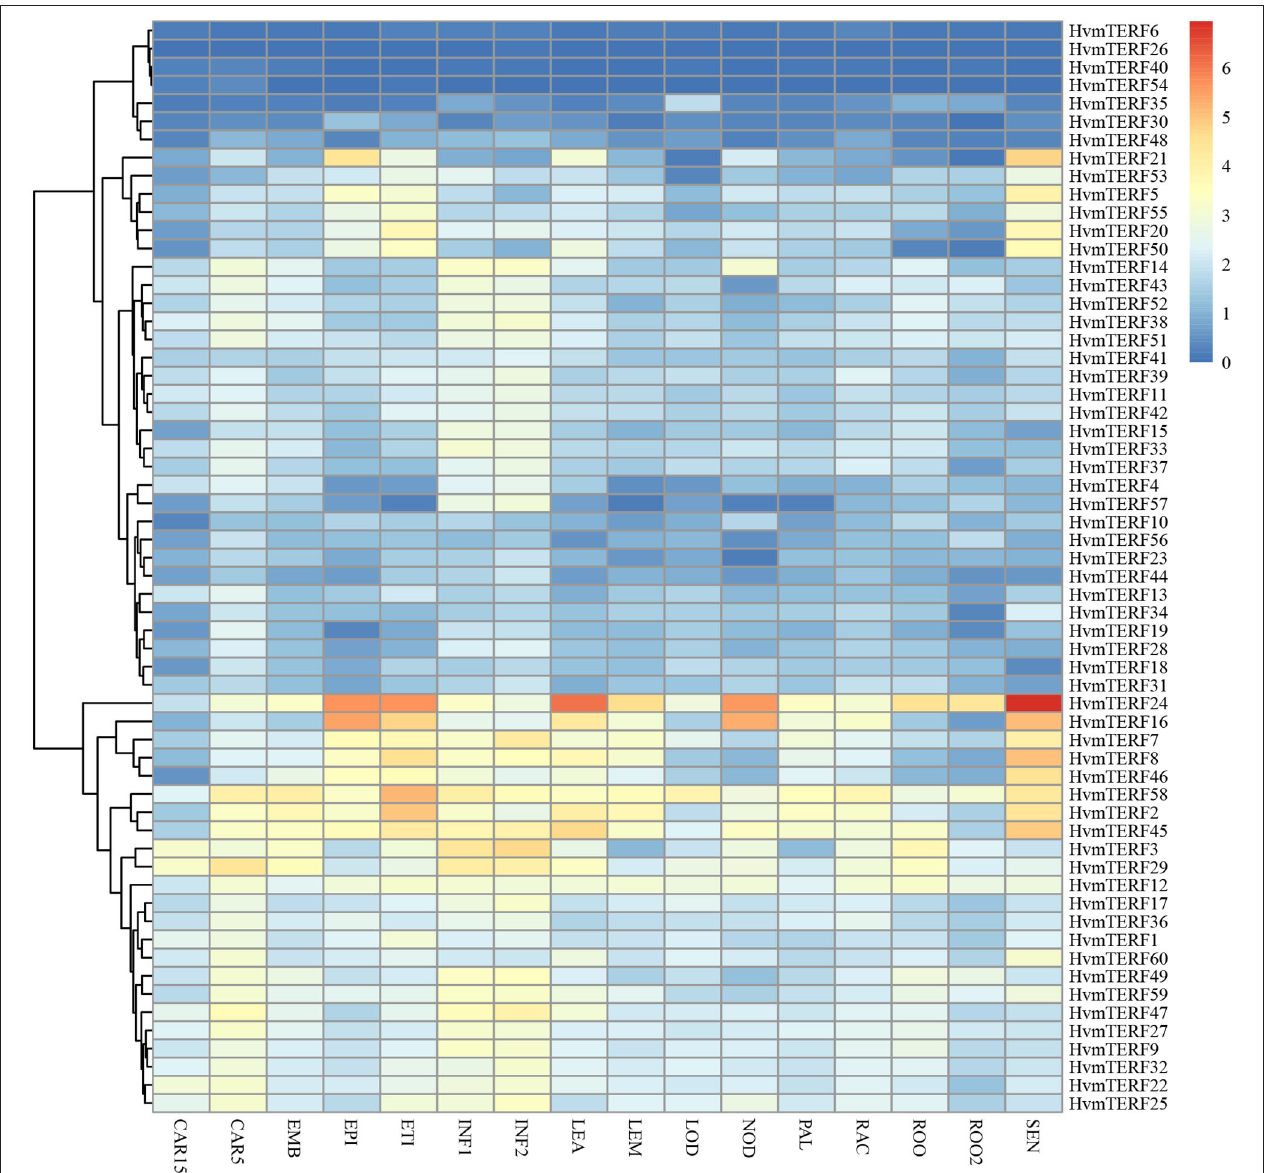
FIGURE 5 | The expression profile of HvmTERF genes at different tissues or stage of barley. FPKM values were normalized by log 2 (FPKM + 1) transform to represent color scores. CAR15/CAR5, developing grain (15/5 day after pollination); EMB, embryonic tissue (4 days); EPI, epidermal strips (4 weeks after pollination); ETI, etiolated seedling with 10 days old after planting; INF1, Young developing inflorescences with 5mm; INF2, developing inflorescences with 1cm; LEA, 10cm shoots from seedlings; LEM, inflorescences, lemma(6 weeks after pollination); LOD, inflorescences, lodicule (6 weeks after pollination); NOD, developing tillers at third stem internode (6 weeks after pollination); PAL, dissected inflorescences, palea (6 weeks after pollination); RAC, inflorescences, rachis (5 weeks after pollination); ROO, roots from the seedlings with 17 and 28 days old after planting; ROO2, roots (4 weeks after pollination); SEN, senescing leaves (8 weeks after pollination).